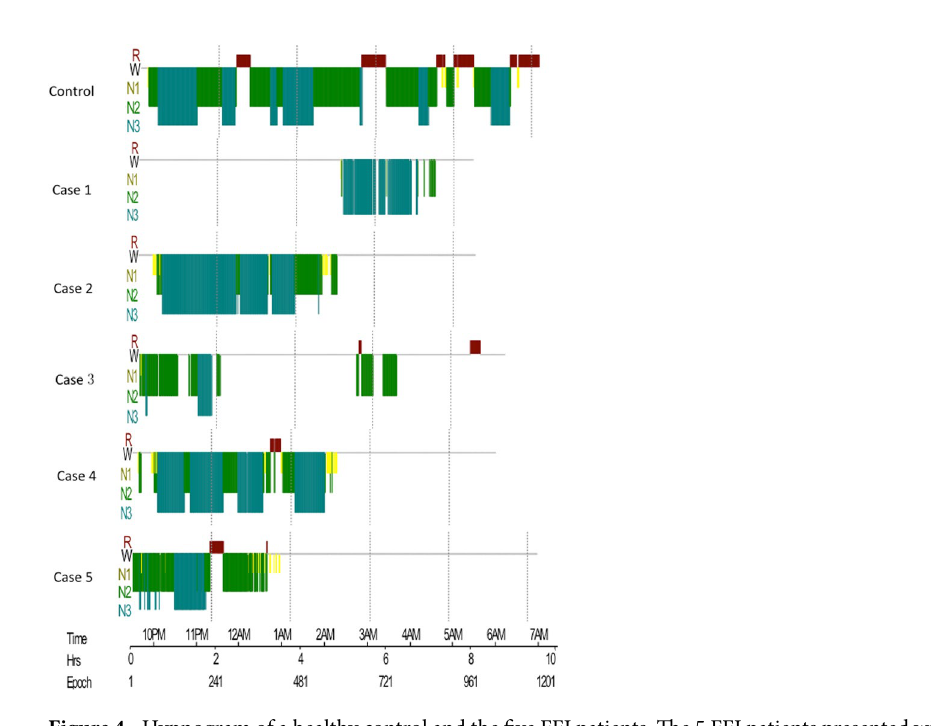
Figure 4. Hypnogram of a healthy control and the five FFI patients. The 5 FFI patients presented with decreased sleep efficiency and disruption of the normal cyclic sleep organization (horizontal axis in sleep hours). W: wake, R: REM, N1-3: NREM sleep